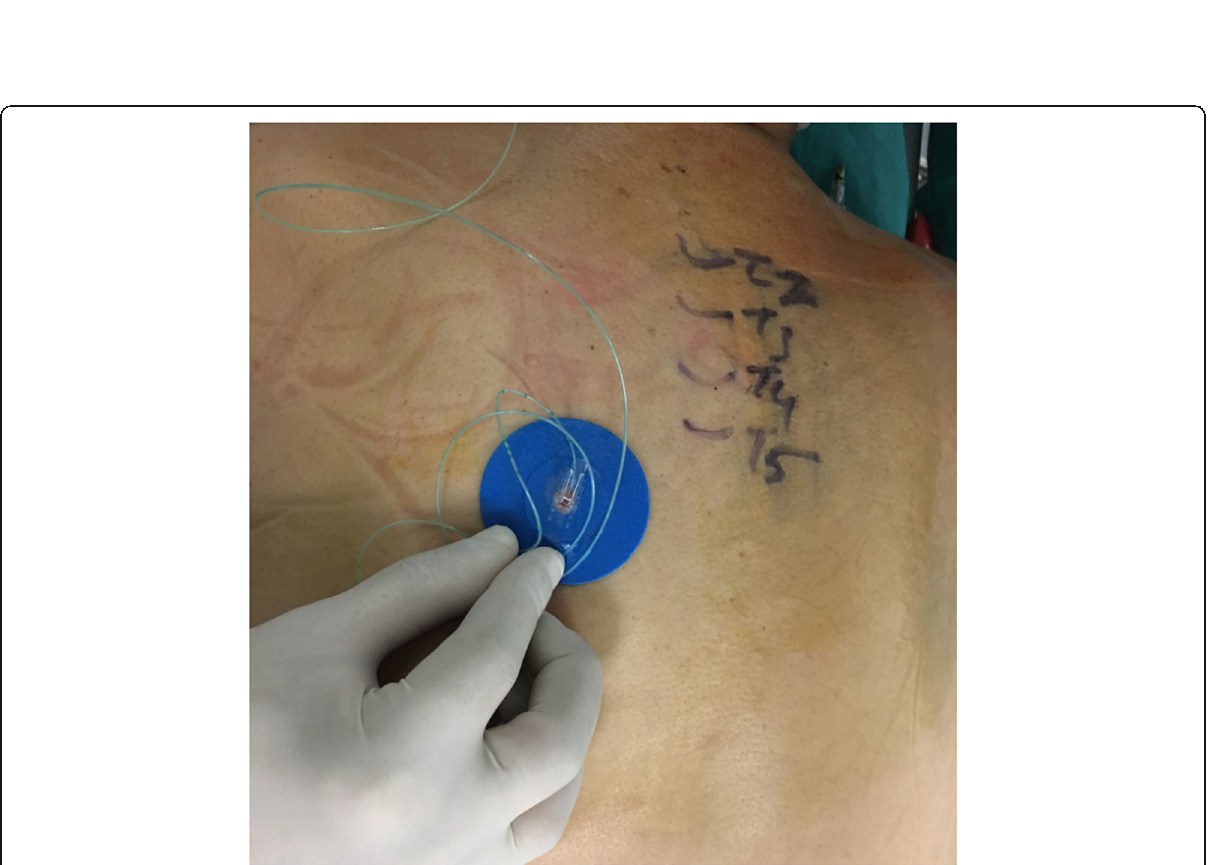
Fig. 3 The secured catheter with the instant skin adherence